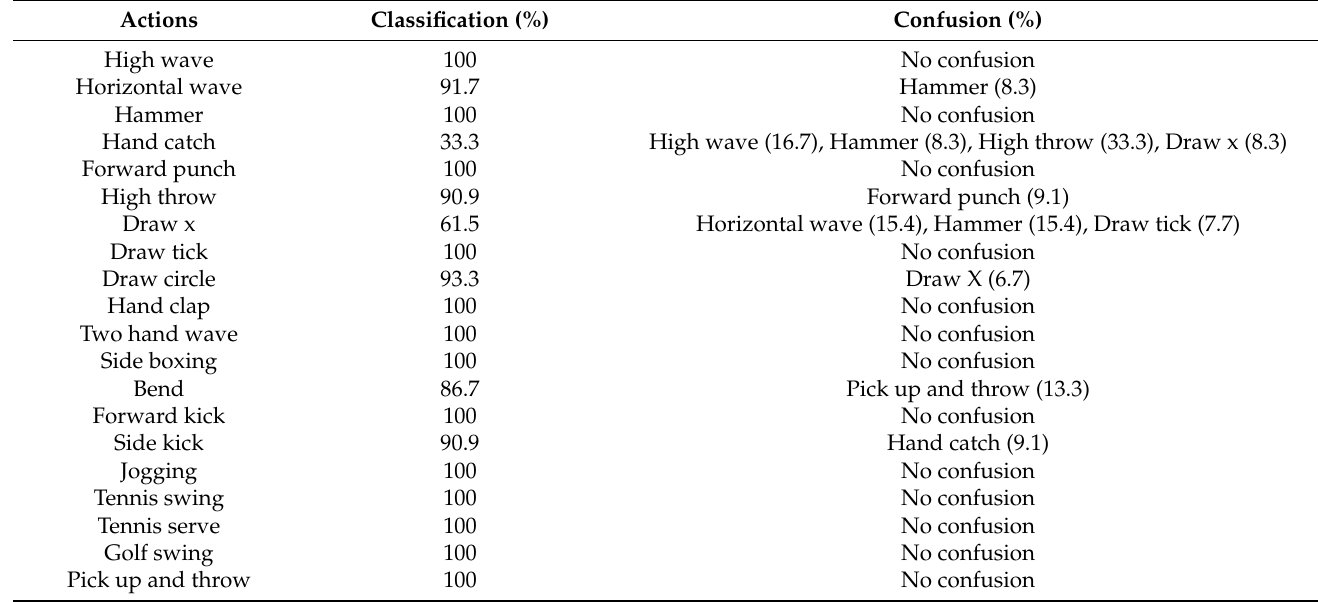
Table 2. Class-specific accuracy on MSR-Action3D